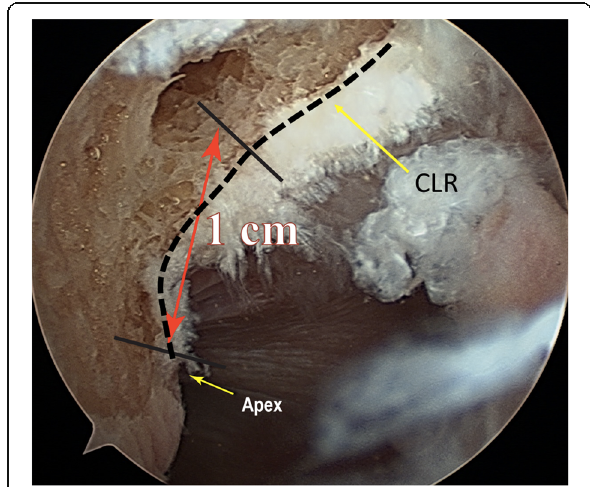
Fig. 3 Arthroscopic view of the lateral notch through the anterolateral approach of a right knee showing the position of the center of the tunnel: close to the CLR and one centimeter higher (anteriorly) relative to the apex of the posterior cartilage. The CLR is marked